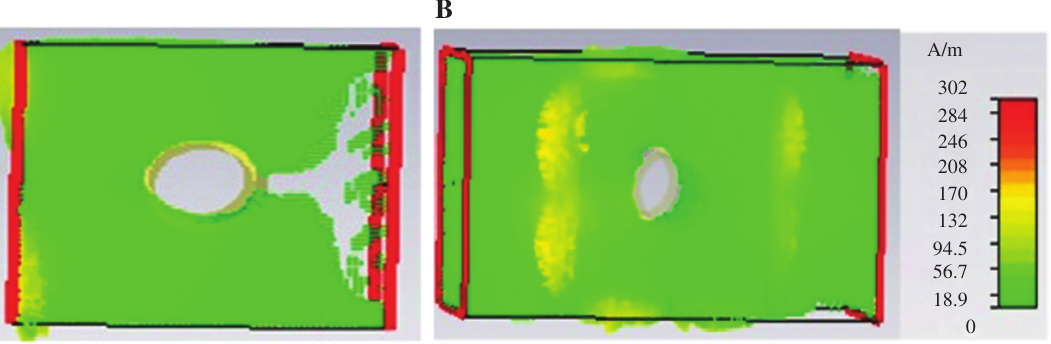
Figure 12: H-field distribution in the xy -plane at cloaked frequency (5.67 GHz) (A) for the bare object and (B) for the cloaked